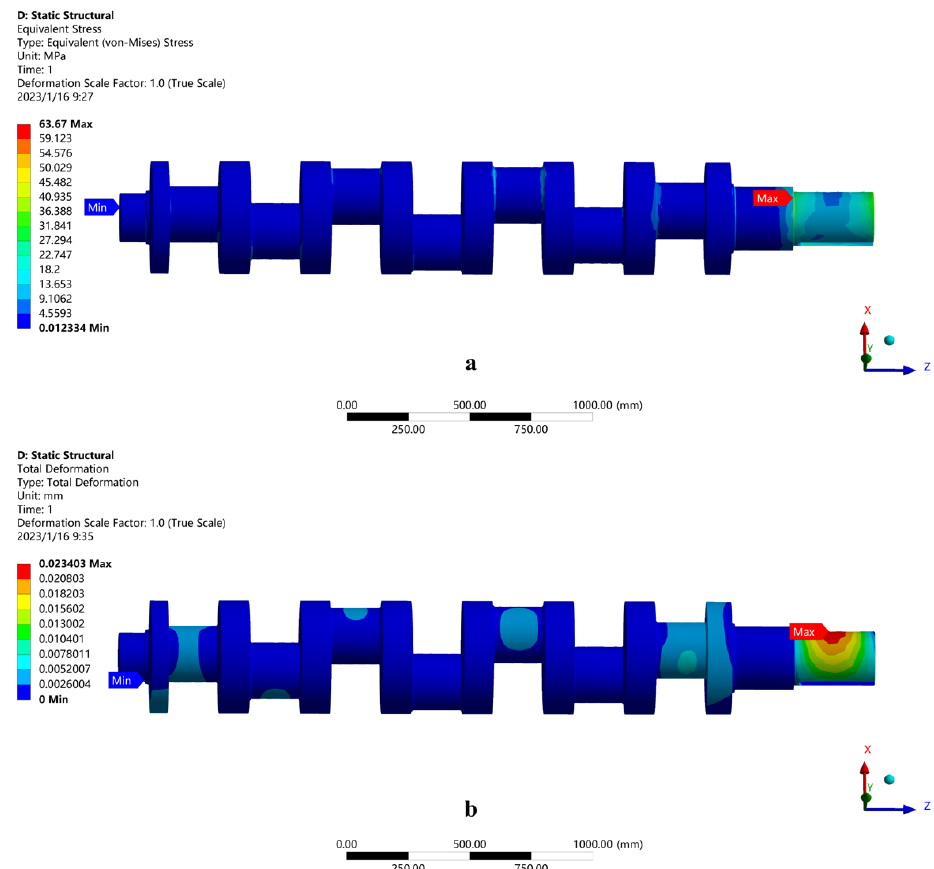
Figure 19. ( a ) Diagram of the maximum equivalent stress of the crankshaft when the first crankshaft angle was 90°, ( b ) Diagram of the maximum shape variable of the crankshaft when the first crankshaft angle was 90°.